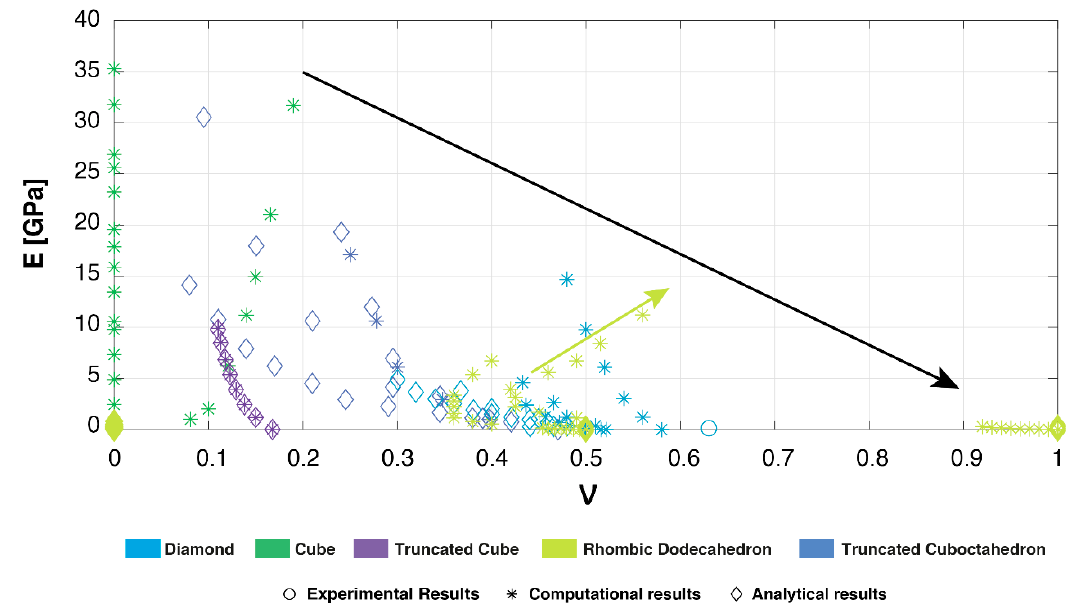
Figure 8. Young’s modulus versus Poisson’s ratio for all of the studied unit cells based on experimental, computational, and analytical data [19,21,22,33,35,42,46] .